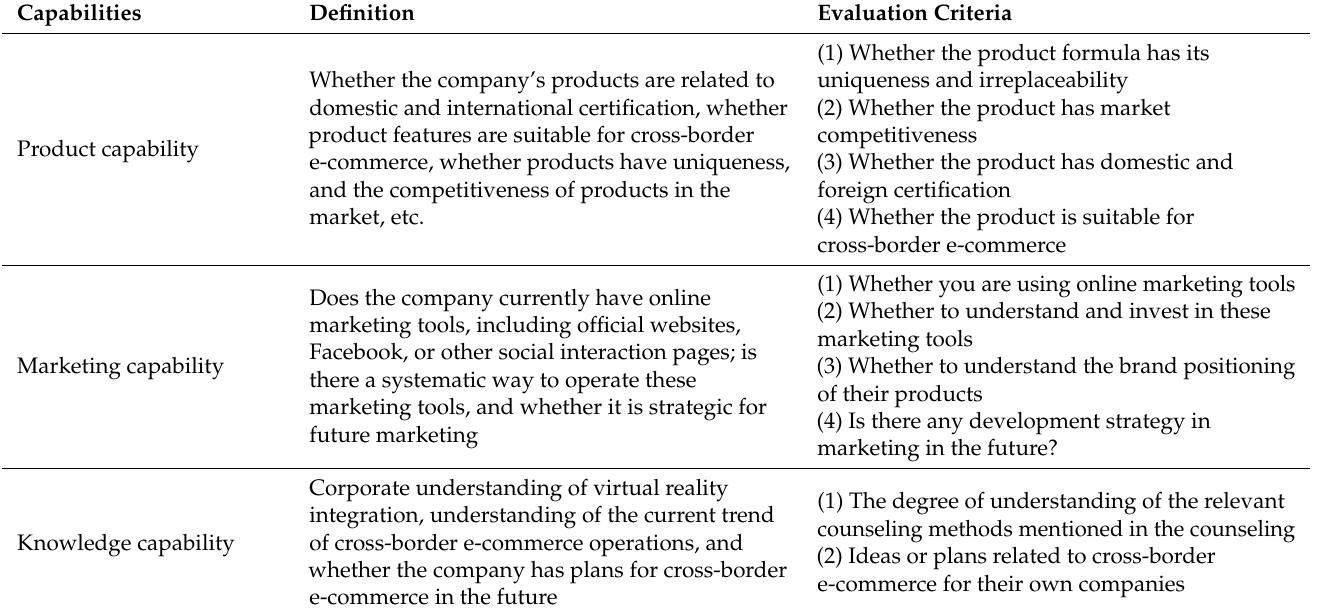
Table 1. Definition and evaluation standards for enterprise